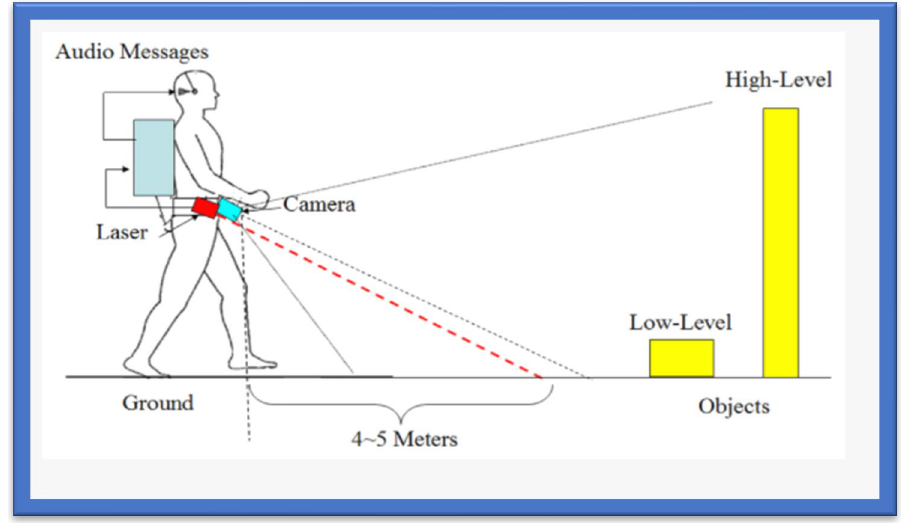
Figure 6. The Blind Audio Guidance System. Table 7. Properties of the Blind Guidance System.